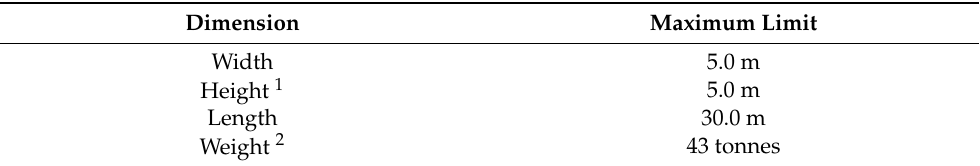
Table 1. Dimension and weight limits to be followed in Victoria, Australia by vehicles transporting houses and prefabricated buildings. Adapted from ref.